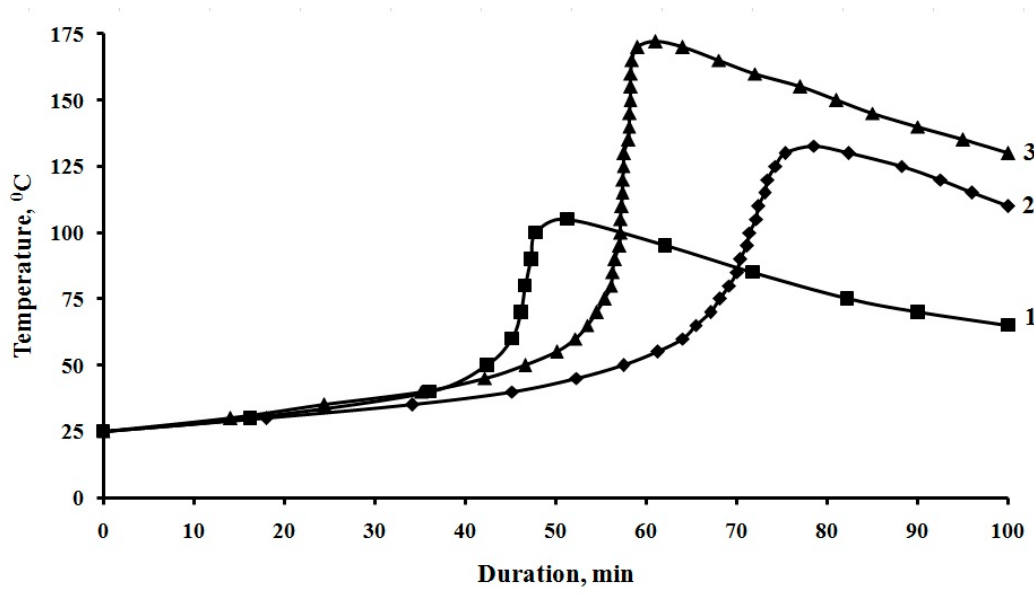
Figure 10. Kinetic curves of the curing process of compositions, parts by mass. 1-100ED-20 + 40TCEP + 15PEPA; 2-100ED-20 + 40TCEP + 0.1MWCNTs + 15PEPA; 3-100ED-20 + 40TCEP + 0,1MWCNTs (APTES) +15PEPA.